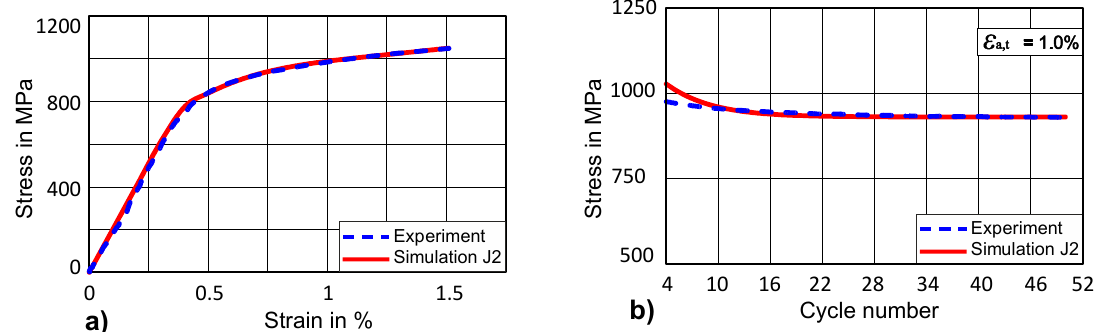
Figure 12. ( a ) Optimised uniaxial stress-strain curve for J2 at ε a,t = 1.5% ( b ) Evolution of stress amplitude for (J2) first 50 cycles.